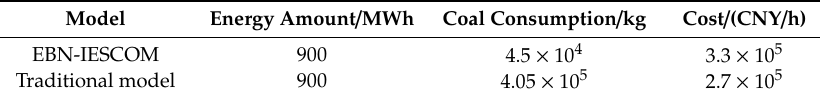
Table 10. Simulation results of energy consumption and cost in ESCO8.